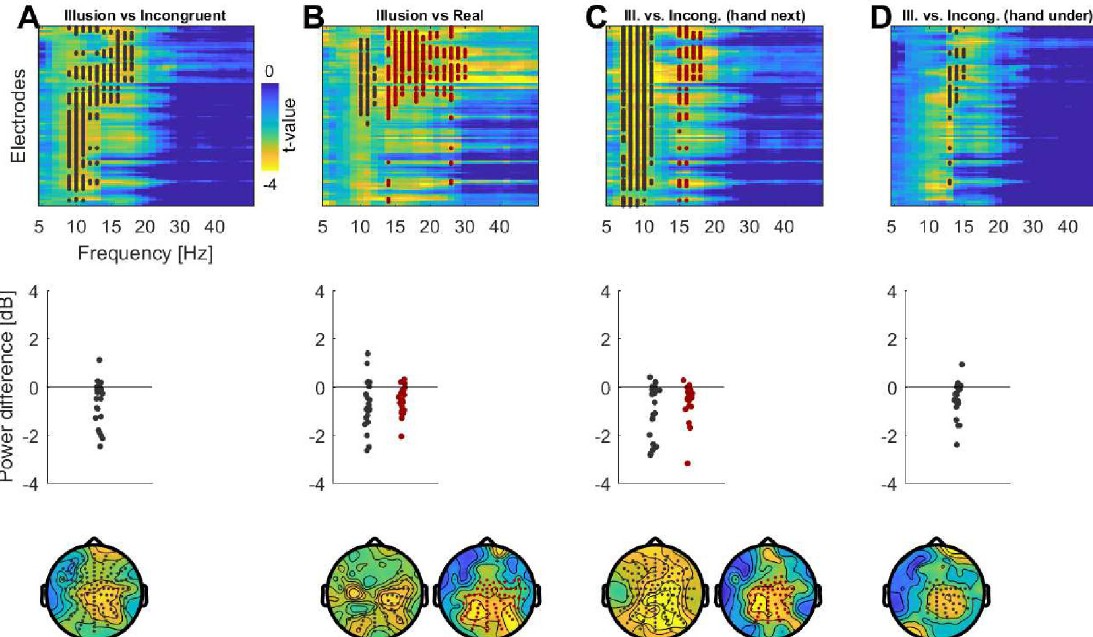
Fig 2. Differences in spectral power between conditions. A, B) Contrasting spectral power between Illusion and Incongruent conditions and between Illusion and the Real condition reveals a significant suppression in alpha and beta bands. The upper panel displays the electrode and frequency wise t-maps for a difference between conditions (two-sided t-test, showing Illusion minus Incongruent/Real). The middle panel shows the participant-wise power differences for the significant cluster(s). The lower panel shows the scalp topographies at the frequencies of the significant cluster(s). C, D) Results for the contrast between Illusion and Incongruent conditions separately for the ‘hand next’ and ‘hand under’ arrangements.